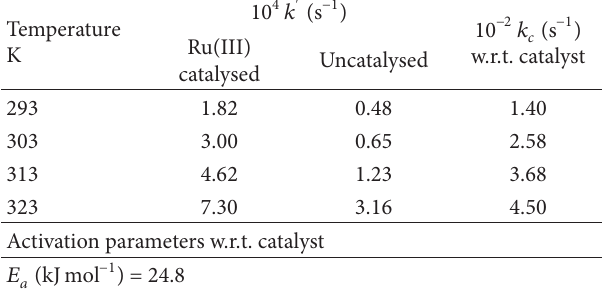
T 4: Effect of varying dielectric constant of the medium on the reaction